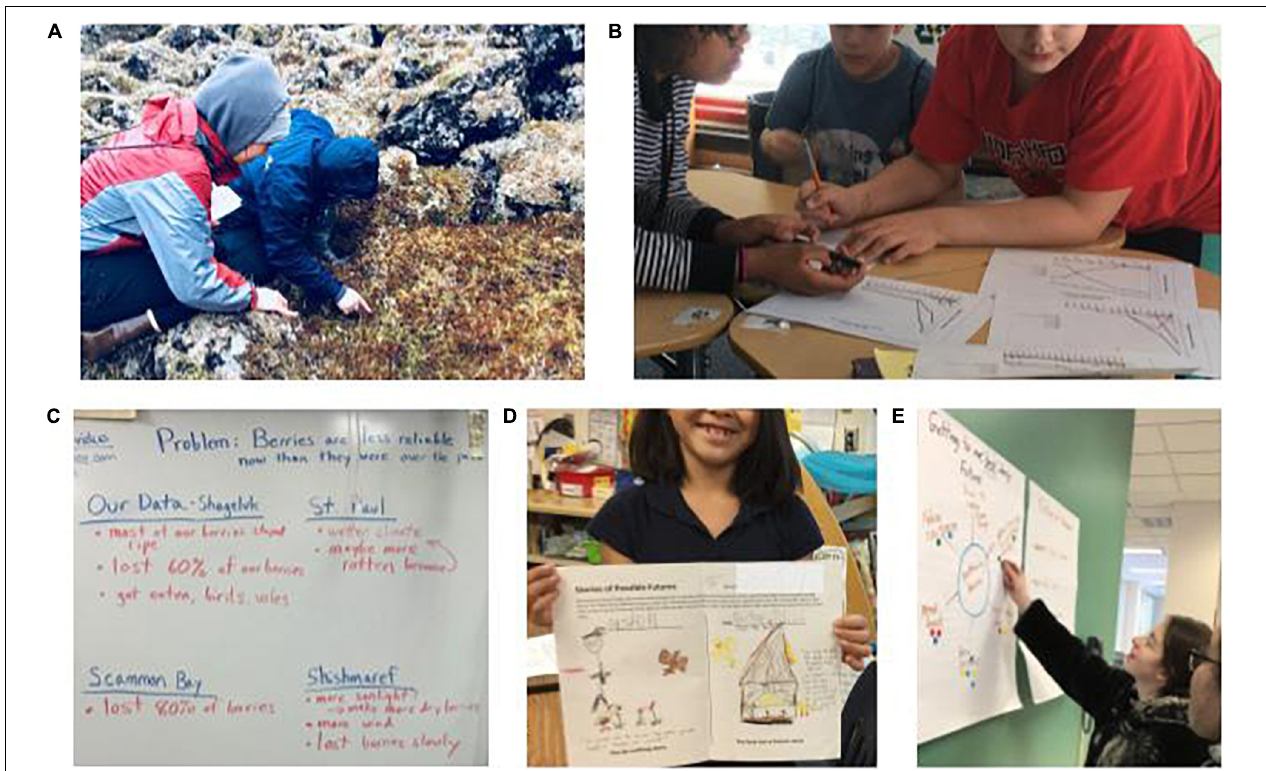
FIGURE 2 | Method for pairing community and citizen science with scenarios storytelling. During the first phase of the activity, students reflected on the berry data they collected in their own field sites (A) and analyzed the patterns using graphs (B) . They compared the patterns in their site to three other sites in the citizen and community science project from other bioclimatic regions (C) to begin to imagine future scenarios of a “do-nothing future” and a “best berry future” (D) . Youth collaborators brainstorm strategies to foster a sustainable amount of berries for future generations to include in their scenarios, and prioritize the actions through a voting activity (E) . Full lesson plan available from Spellman et al.